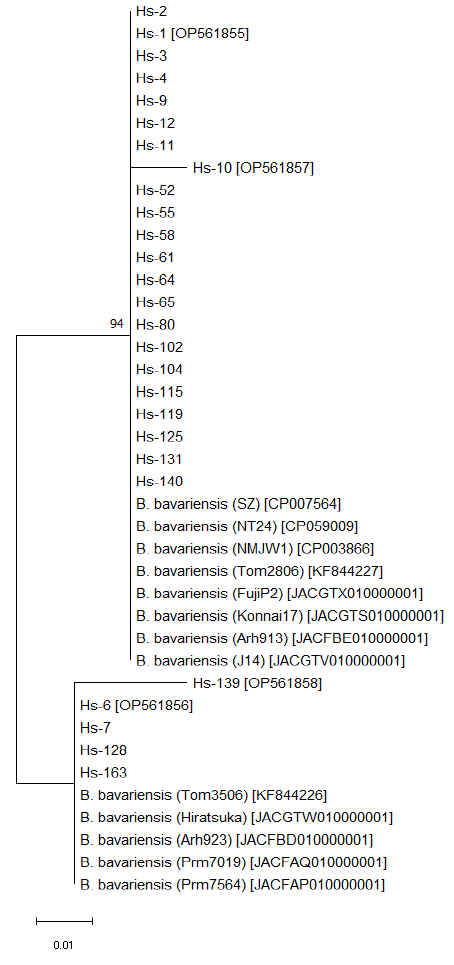
Figure 3. Dendrogram of amino acid sequences of P66 from B. bavariensis isolates. Created using Jones-Taylor-Thornton model and maximum likelihood method (MEGA11 software; bootstrap 1000 repeats). GenBank numbers are between brackets.